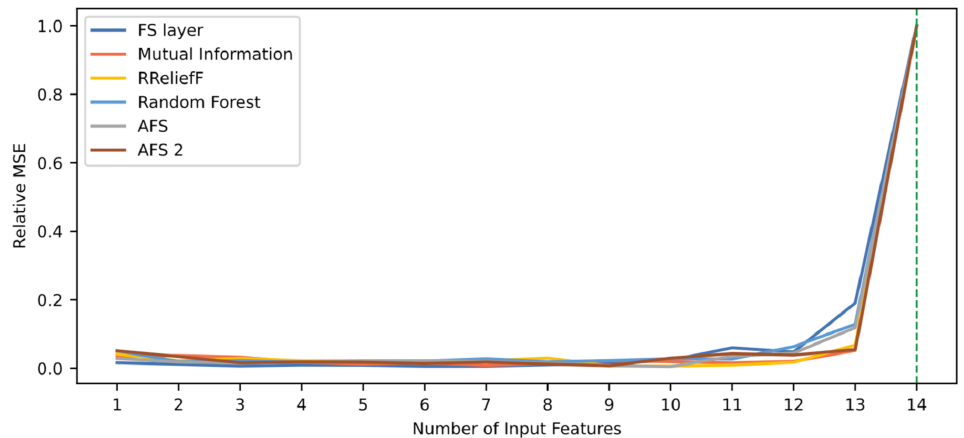
Figure 12. Comparison of relative MSE based on six different rankings for C-MAPSS FD004 dataset. The green dotted line indicates the number of features needed when using the FS layer technique to reach a 95% of the maximum performance